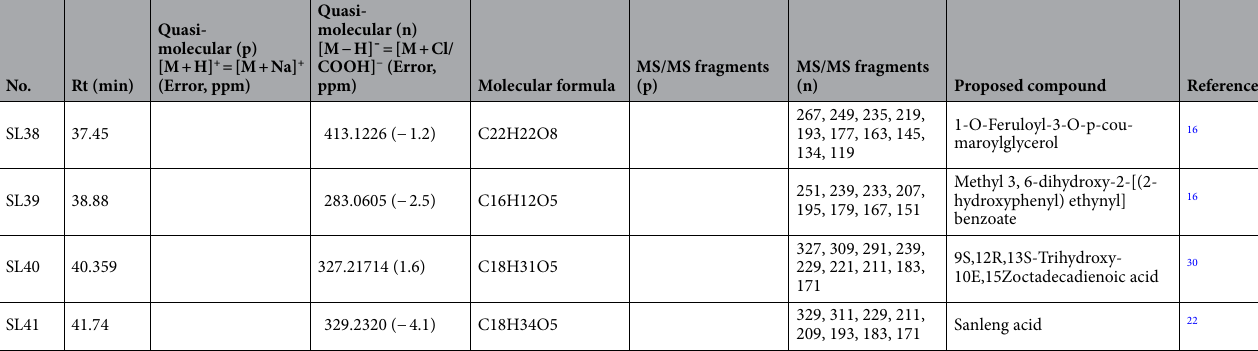
Table 1. The compounds identified of Sparganii rhizoma.